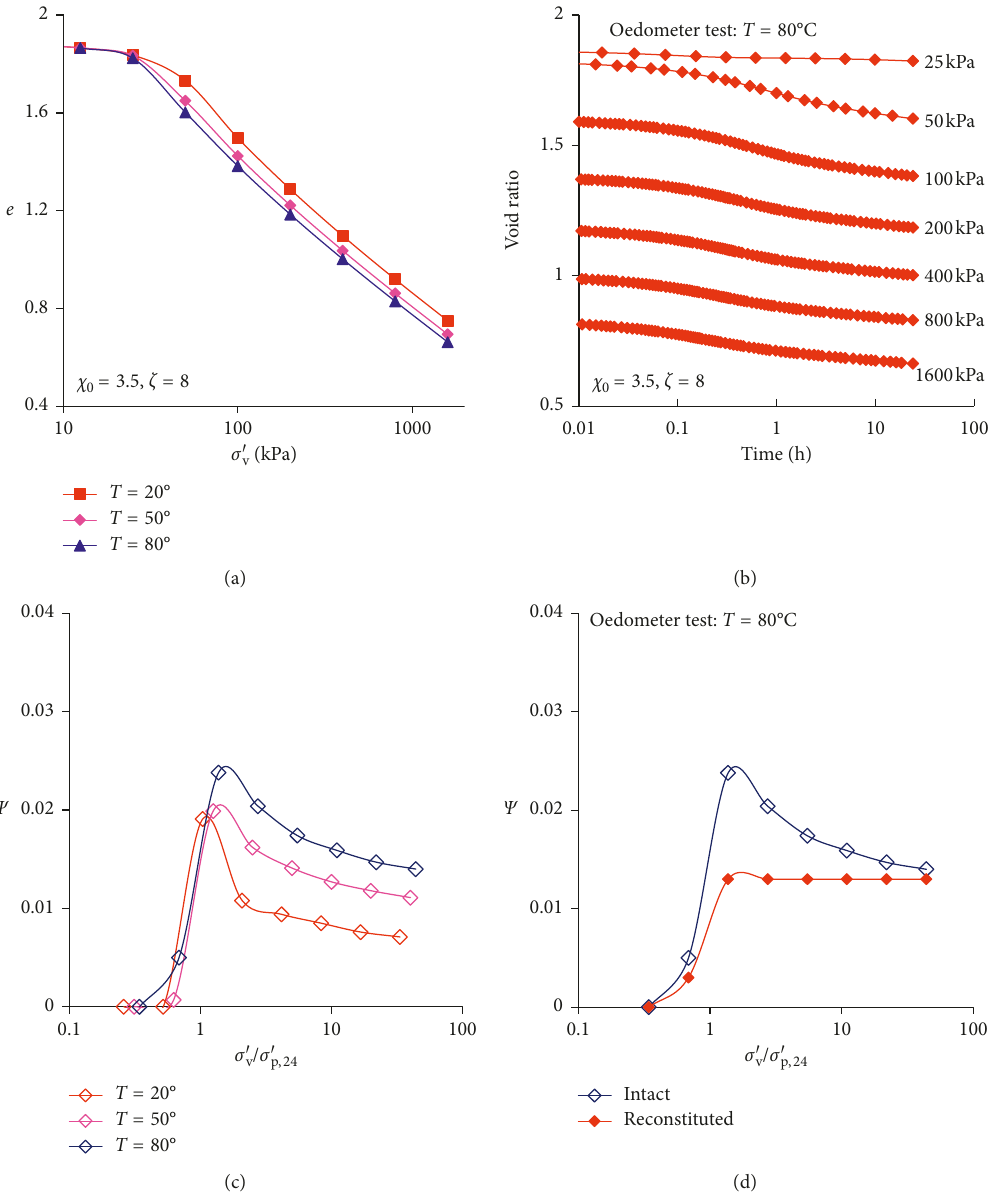
Figure 7: Predictions of the thermal oedometer test on Wenzhou clay with different temperatures: (a) compression curves at different temperatures; (b) strain-time curves for the case with T 80 ° C; (c) evolution of the thermal creep coefficient with normalized vertical stress; (cid:31) (d) comparisons of the thermal creep coefficient between intact and reconstituted